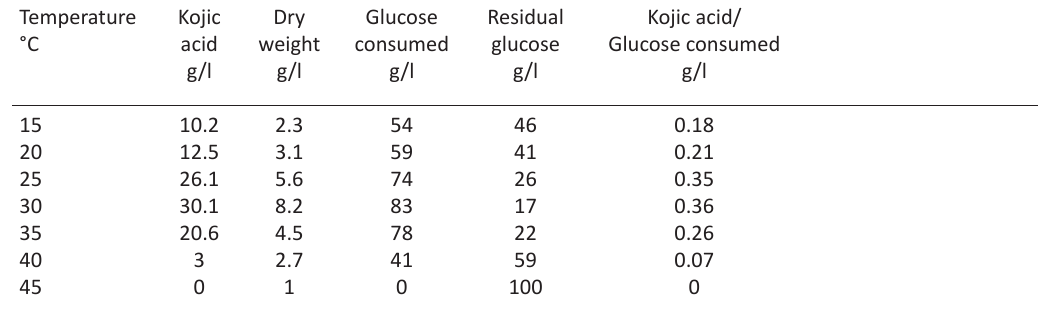
Table 7. Effect of incubation temperature on kojic acid production, drymass and consumption of sugar by A.flavus Temperature Kojic Dry Glucose Residual Kojic acid/ °C acid